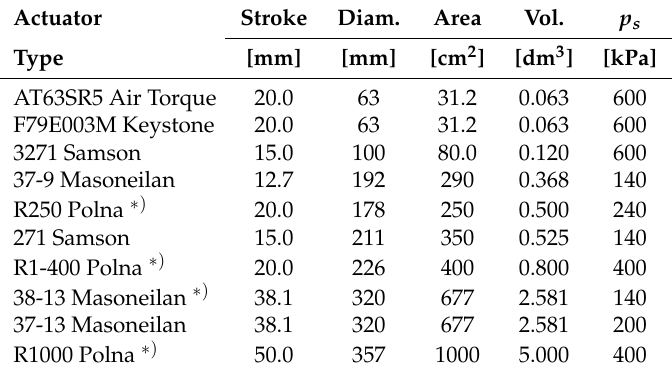
Table 1. The set of main parameters of the investigated